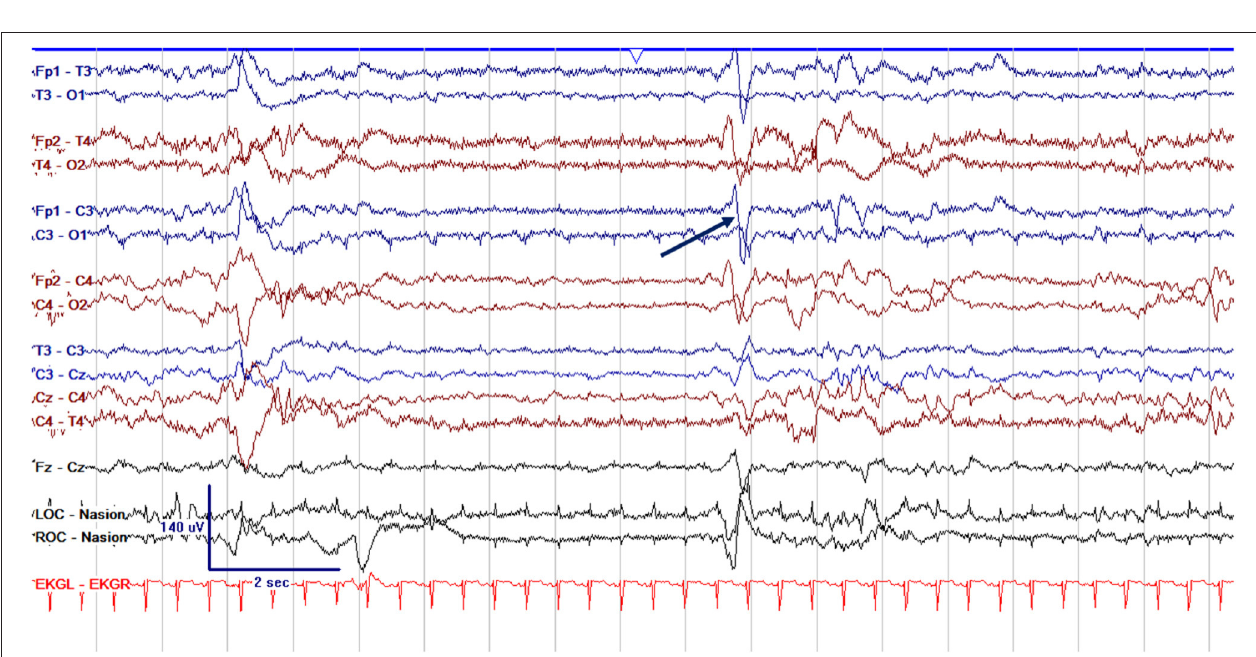
FIGURE 4 | Abnormal excessively discontinuous cEEG background in a term neonate, a 1 day old former 39 + 0 week GA (39 + 1 PMA) with interburst intervals lasting > 6s with voltages < 25 µ V. Normal graphoelements, encoche frontales–normal frontal sharps, are seen (arrow).